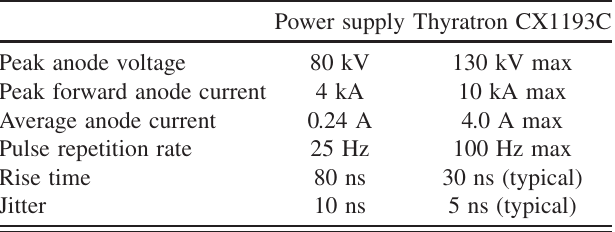
TABLE II. Comparison between the required specifications of the kicker power source and the abridged data of the thyratron CX1193C.